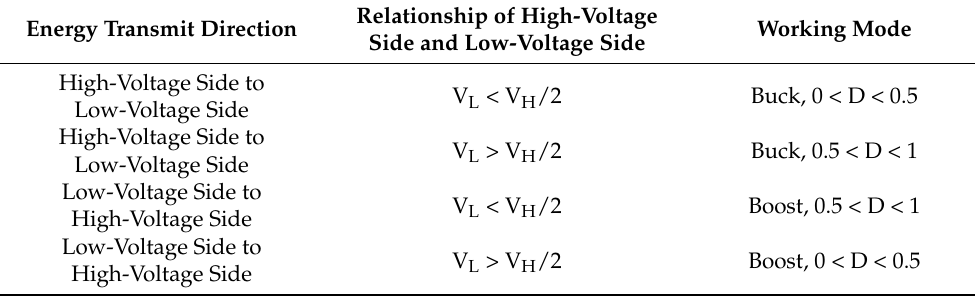
Table 1. The working modes of FC-3L-BDC.